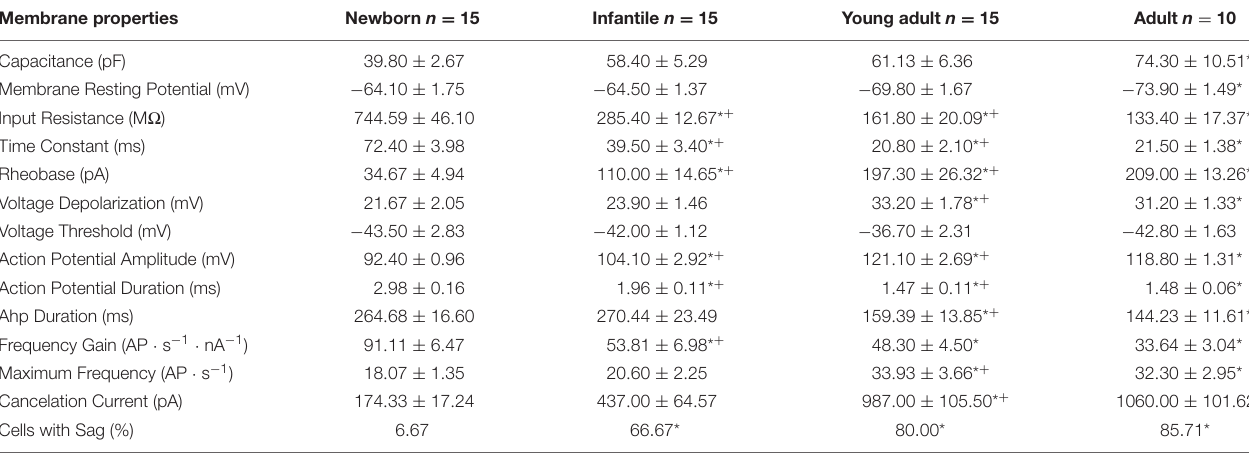
TABLE 1 | Electrophysiological properties of pyramidal neurons from the motor cortex during postnatal development. Membrane